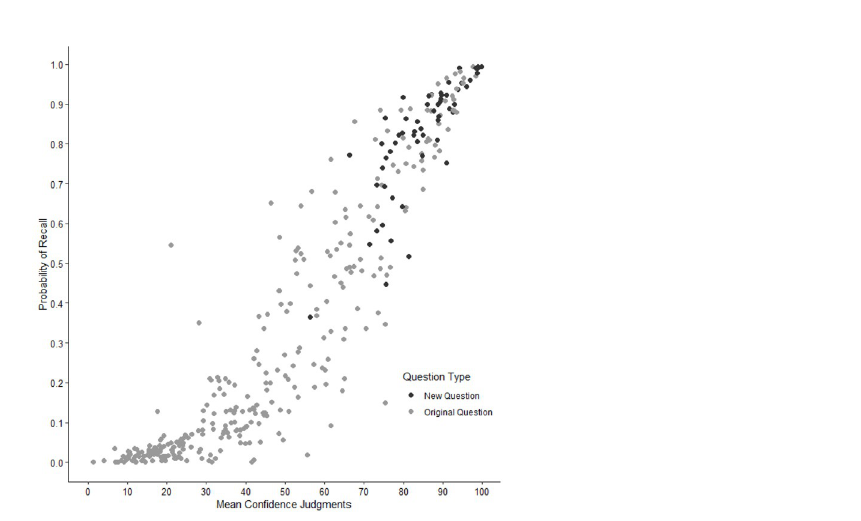
Fig 4. Association between probability of recall and mean confidence judgment per question. Each dot represents one question. Confidence judgments were only analyzed for given responses. Higher mean confidence judgments per question were associated with higher probability of recall.